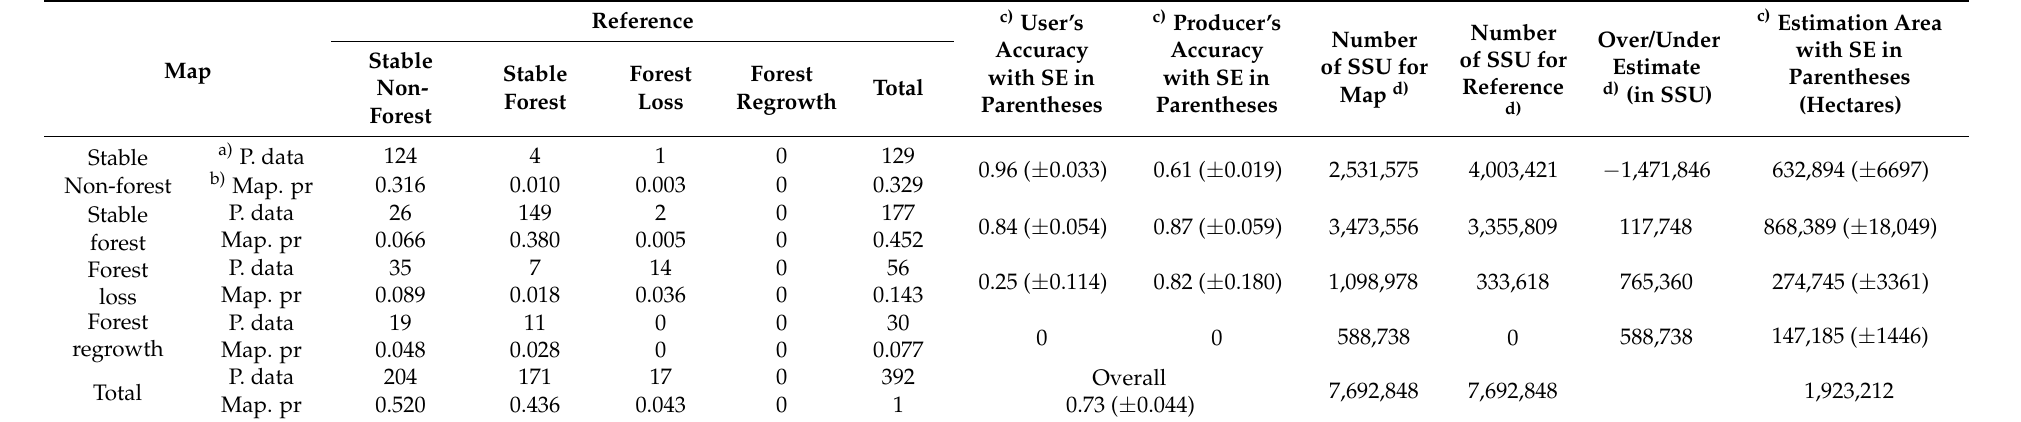
Table A5. Description of population data and map proportion area confusion matrix for the automated digital processing of land cover change map in 2012–2018.